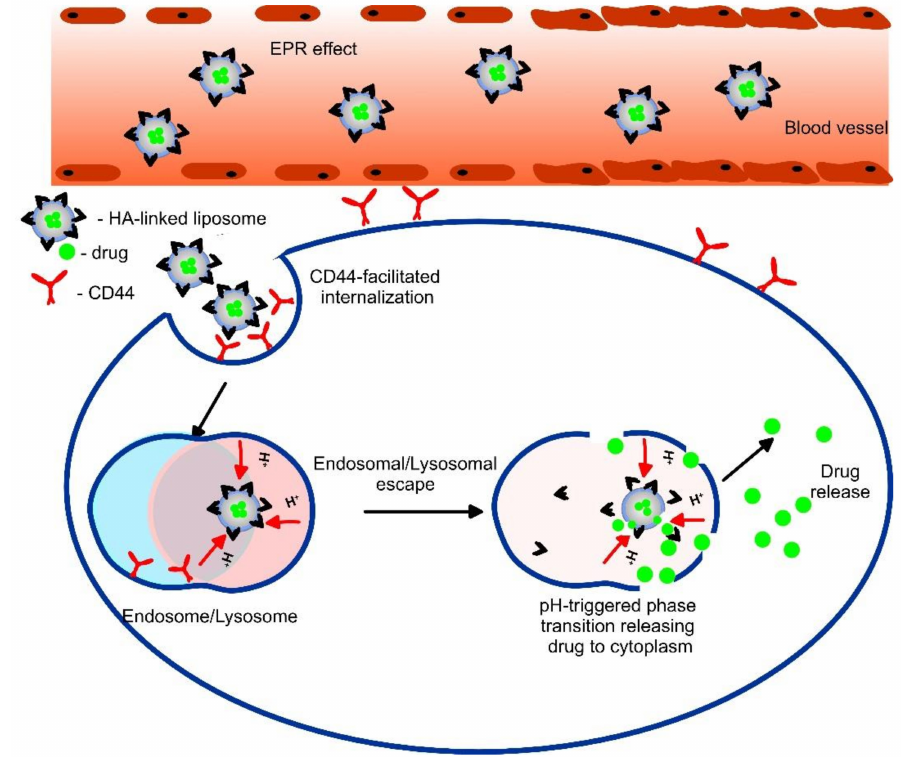
Figure 8. After leaving the blood vessels because of the EPR effect, HA-modified pH-sensitive liposomes undergo CD44-facilitated internalization. At slightly acidic pH in endosome/lysosome, the acid-sensitive moieties undergo protonation, leading to disruption of the liposome and release of a drug inside the tumor